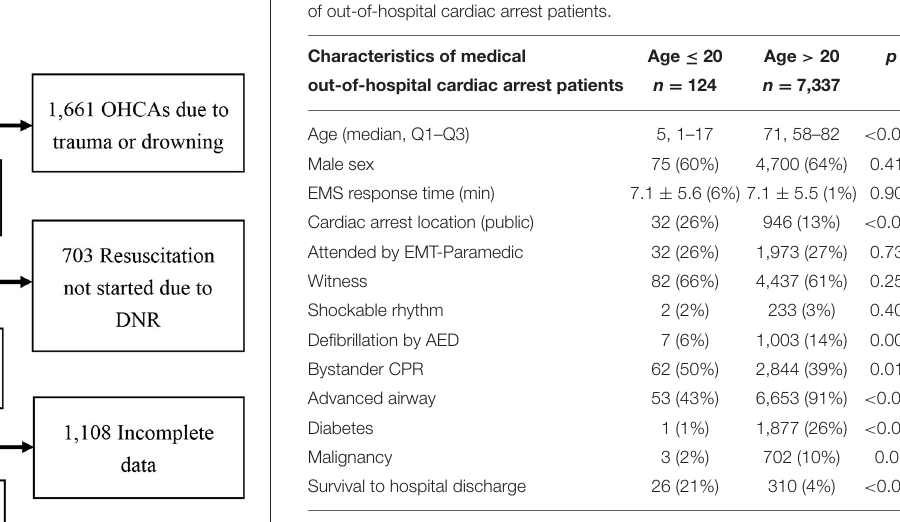
type plots. Statistical significance was set at p < 0.05. All statistical analyses were performed using IBM SPSS Statistics for Windows,